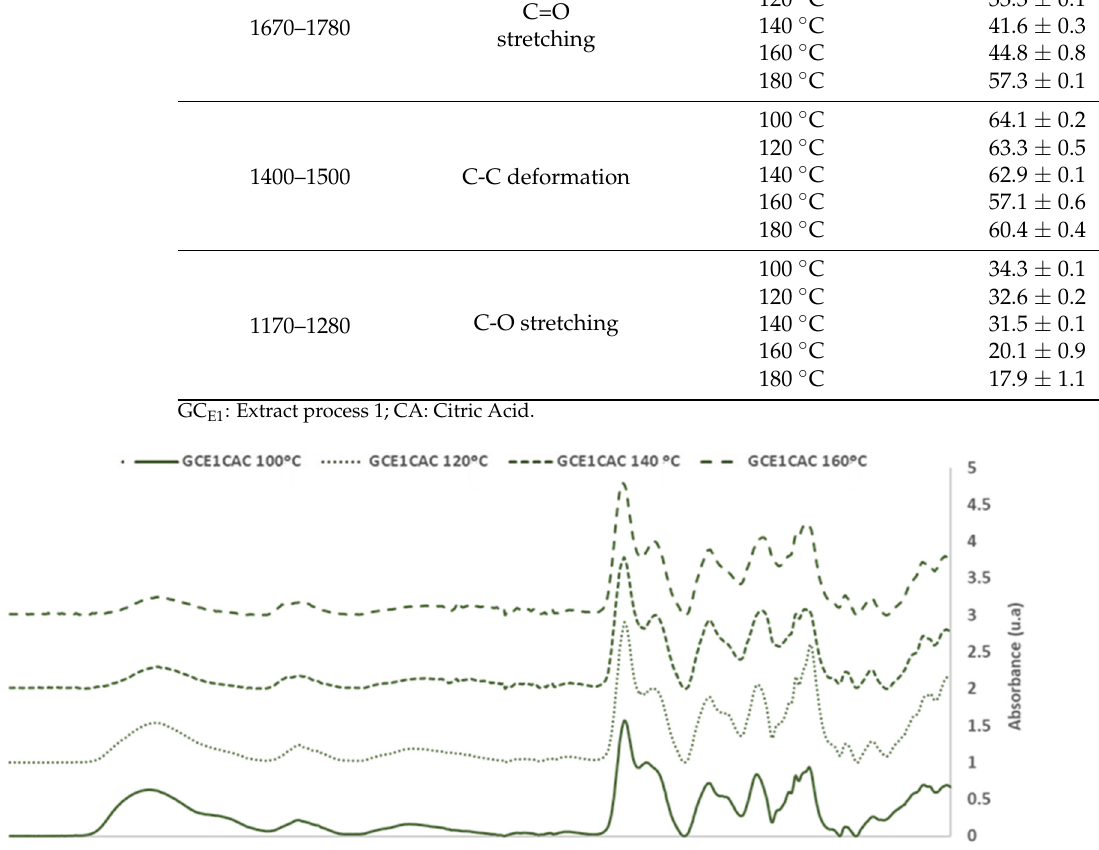
Figure 10. FTIR spectra: Citric acid and Grape cane extract GCE1 cured with citric acid (43% on adhesive weight, dry basis) at 100–180 °C (600–1800 cm − 1 ). The changes of the main bands in the polymerization process are shown in Table 7. Table 7. Polymerization degree for the GC E1 + CA (43% on adhesive weight, dry basis), cured at 100–160 °C during 120 s. Wavenumber (cm − 1 )